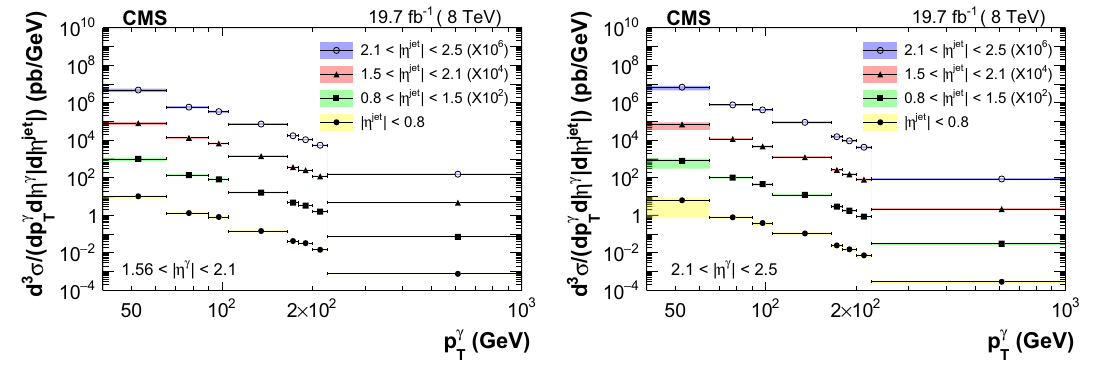
Fig. 4 Measured triple-differential cross section distributions as a γ functionof p indifferentbinsof | η jet | forphotonsintheendcapregion. T Note that the distributions are multiplied by a factor of 10 2 , 10 4 and